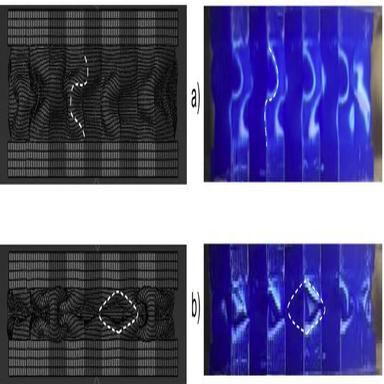
Comparison of simulated and experimental deformation during quasistatic compression: a) 2 mm, b) 6 mm. Note, simulated images have been flipped horizontally to better highlight the similar deformation patterns.